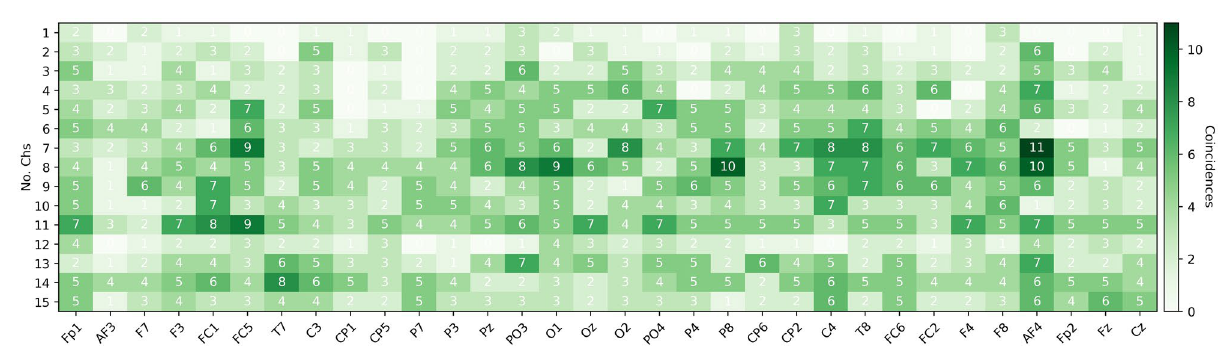
Figure 8. EEG channels selected for 2-s segments classification of low and high arousal using EEGNet and